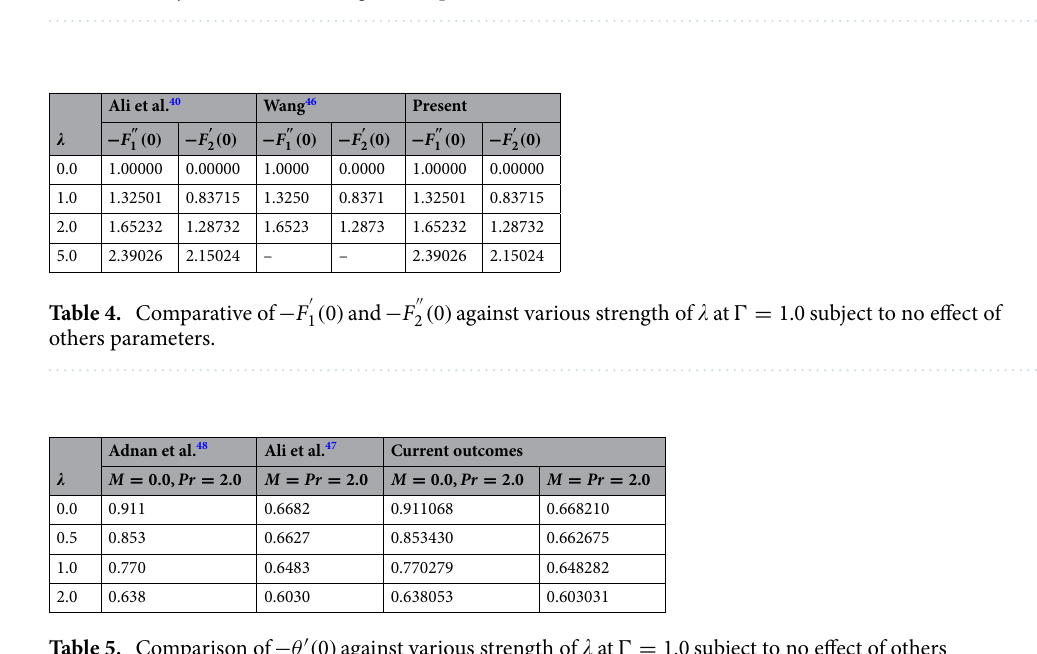
Table 5. Comparison of